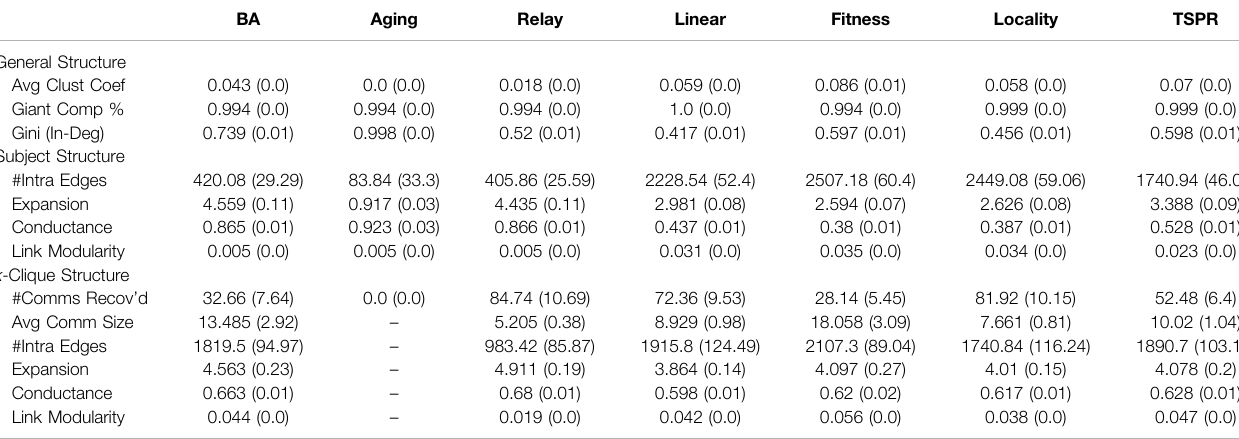
TABLE 1 | Simulated properties for sum-normalized and relay models. BA